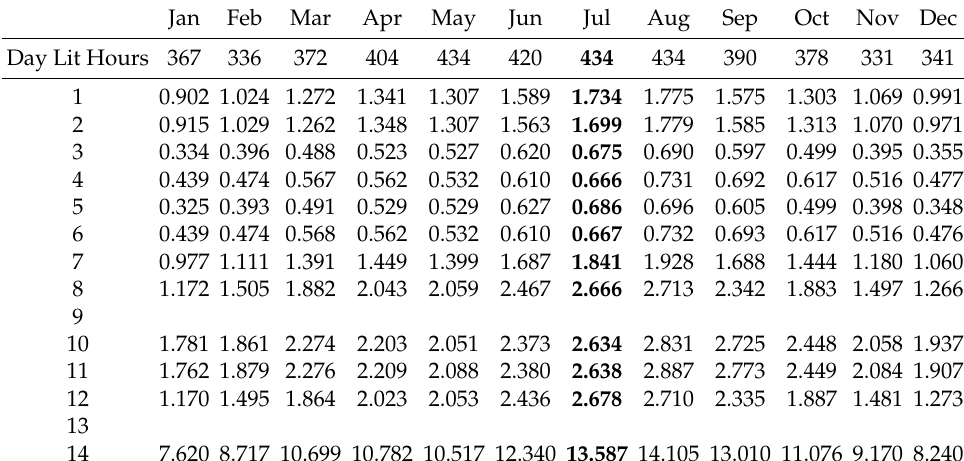
Table 1. Average Hourly Solar Potential per roof segment